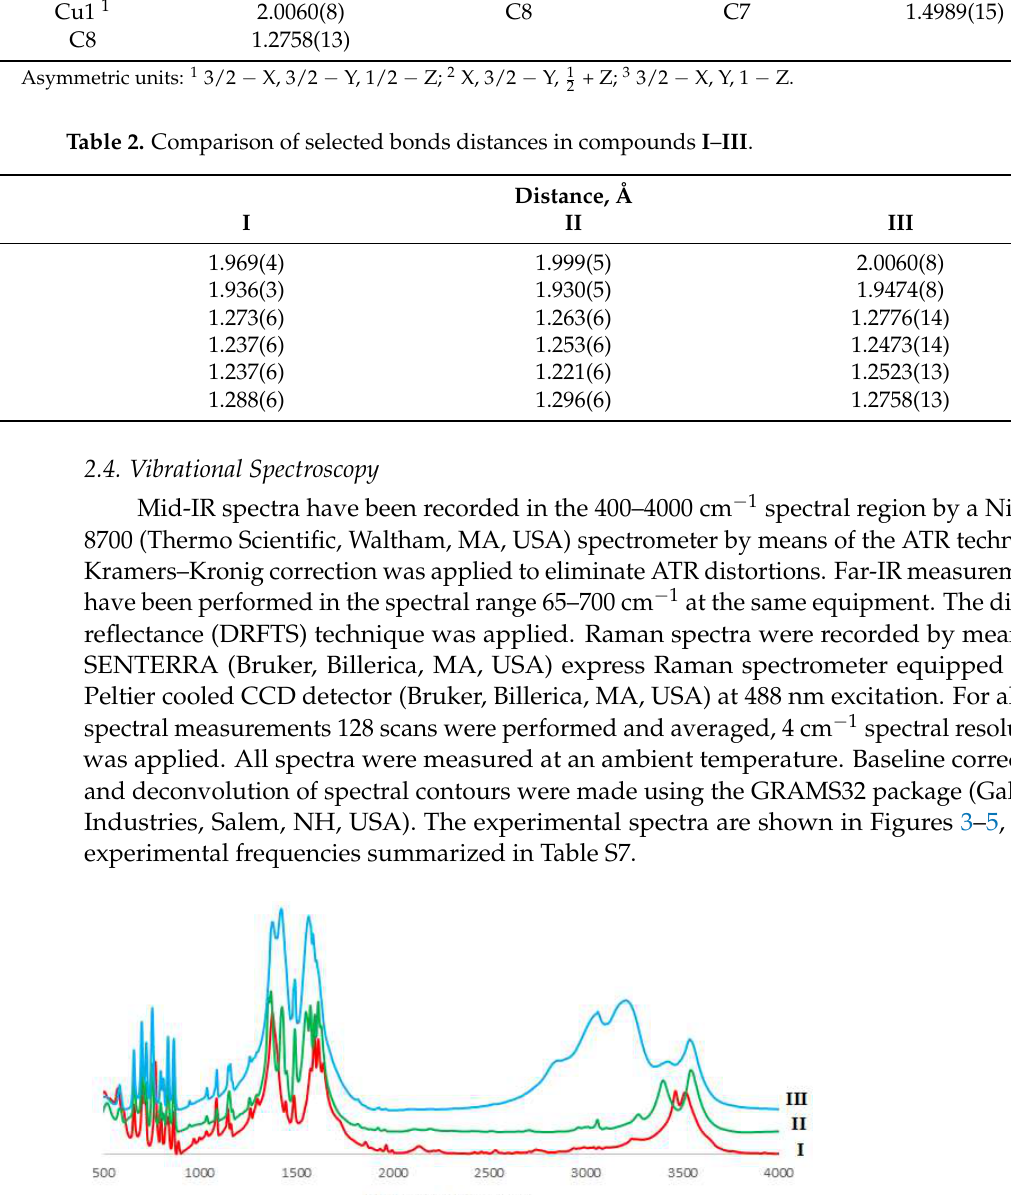
Figure 4. Far-IR spectra of o -phthalatocuprates. Figure 5. Raman spectra of o -phthalatocuprates. Vibrational bands that appear only in the spectra of compounds I – III and are absent in spectra of neat acid were assigned to copper–oxygen stretchings. They were observed as weak to medium intensity bands at 306–307 cm −1 (Raman) and 317–319 cm −1 (IR). As the geometry of the copper ion coordination sphere is very close to the square planar, we assigned the Raman active frequency to symmetric and another to asymmetric stretching. To understand in more detail the bonding in alkaline phthalatocuprates, we have undertaken force-field calculations. Though the force constant reflects the slope of the po- tential energy surface near equilibrium points, for similar molecules, the close relationship in trends for stretching force constants and bond energies is well known. C 6 H 4 (COOCu) 2